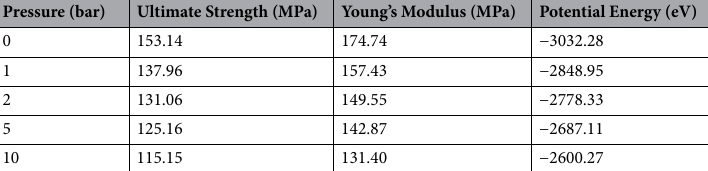
Table 3. The BAG’s atomic/mechanical properties function initial pressure in the MD simulation box.